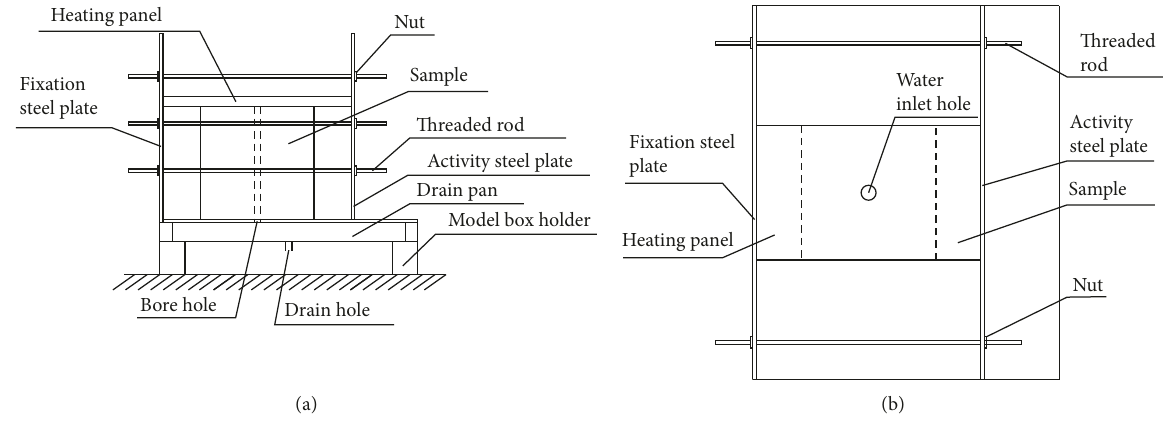
Figure 1: Container used in experiments. (a) Front view. (b) Top